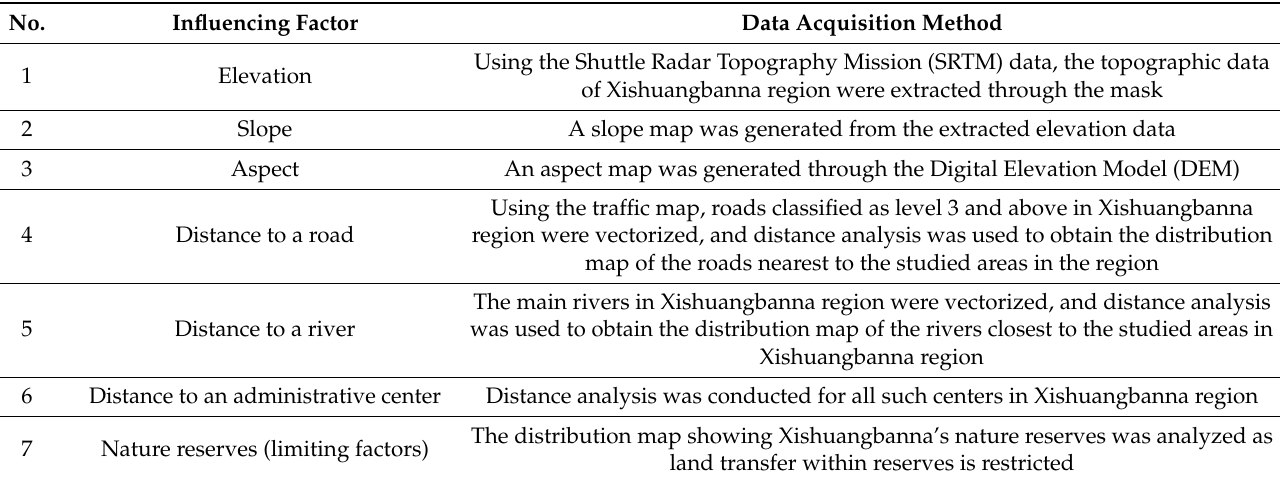
Table 3. Factors influencing land use change and data acquisition